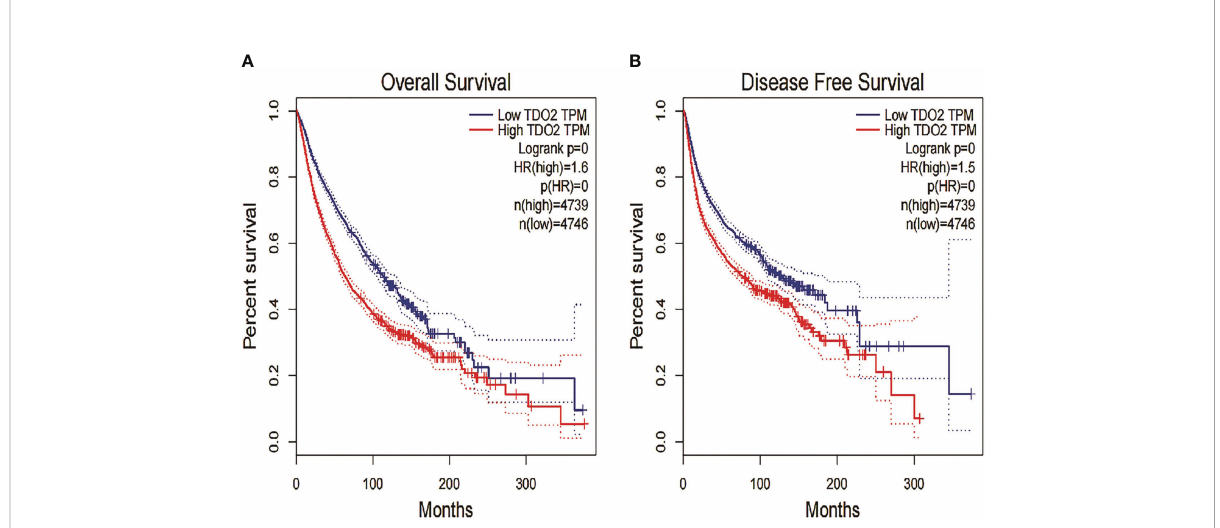
FIGURE 4 Kaplan – Meier plotter showed the prognostic role of high and low expression of TDO2 mRNA expression in OS/DFS. (A) OS in malignant tumor patients. (B) DFS in malignant tumor patients. HR, hazard ratio; CI, con fi dence interval; OS, overall survival; DFS, disease-free survival;TDO2, tryptophan 2,3-dioxygenase; TPM, transcripts per kilobase of exon model per million mapped